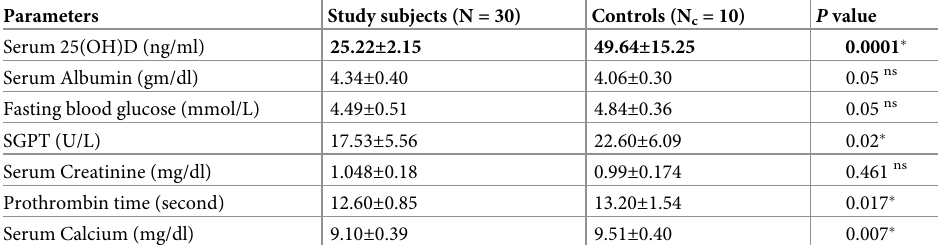
Table 2. Biochemical parameters of the study subjects (N t = 40).